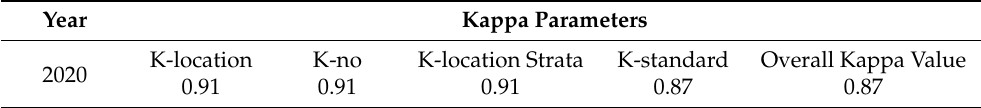
Table 9. Validation results of the CA–Markov model.